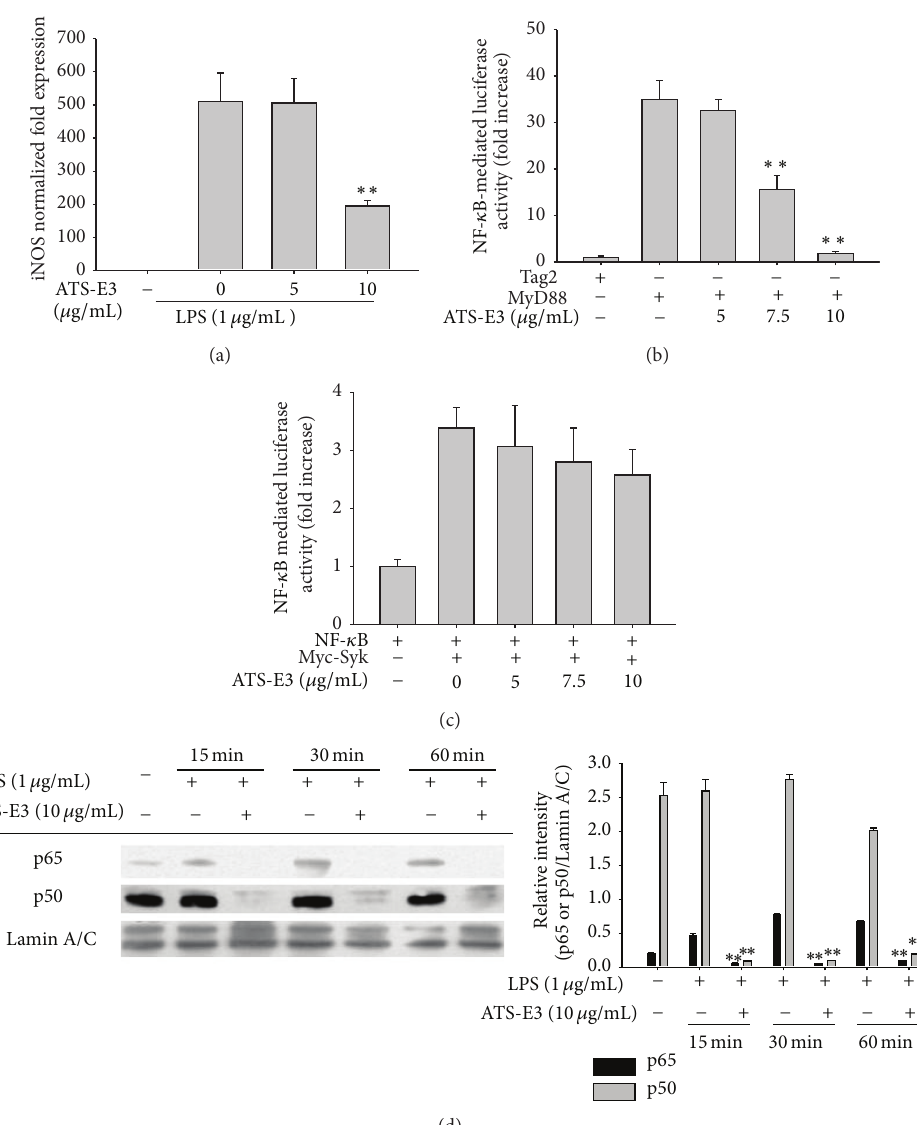
Figure 3: Effect of ATS-E3 on the transcriptional activation of RAW264.7 cells during TLR signaling. (a) The level of iNOS mRNA in RAW264.7 cells treated with ATS-E3 (0 to 10 𝜇 M) in the presence or absence of LPS (1 𝜇 g/mL) for 6h was determined by real-time quantitative RT-PCR. ((b) and (c)) HEK293 cells cotransfected with NF- 𝜅 B-Luc and 𝛽 -gal (as a transfection control) plasmid constructs were treated with ATS-E3 under the cotransfection conditions with FLAG-MyD88 or Myc-Syk (1 𝜇 g/mL each) for 12 h. Luciferase activity was determined using luminometery, as described in Section 2. (d) RAW264.7 cells (5 × 10 6 cells/mL) were incubated with LPS (1 𝜇 g/mL) in the presence or absence of ATS-E3 for the indicated times. After preparing the nuclear fractions, the translocated levels of total transcription factors (p65, p50, and lamin A/C) were identified using immunoblotting. Relative intensity was calculated using total levels by the DNR Bio-Imaging System. ∗∗ 𝑃 < 0.01 compared to control group.